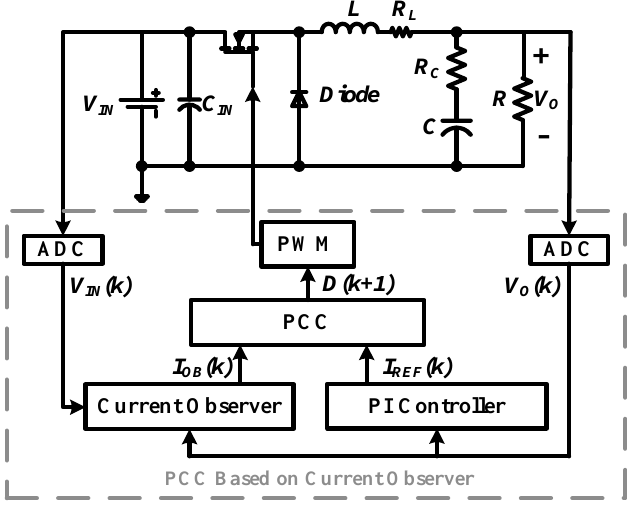
Figure 1. Buck DC-DC converter with the CO based PCC